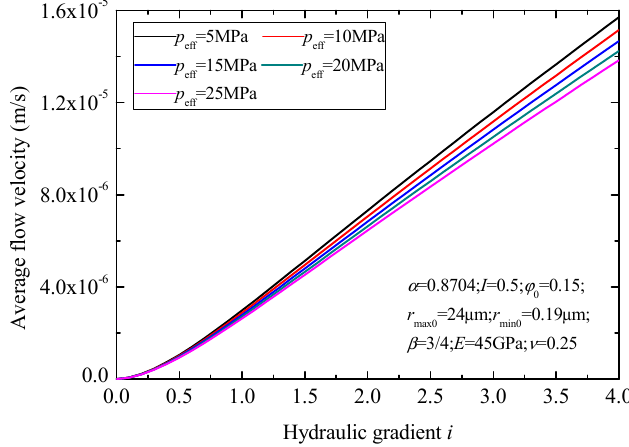
Figure 4. The average flow velocity curves versus hydraulic gradient with different effective stress.